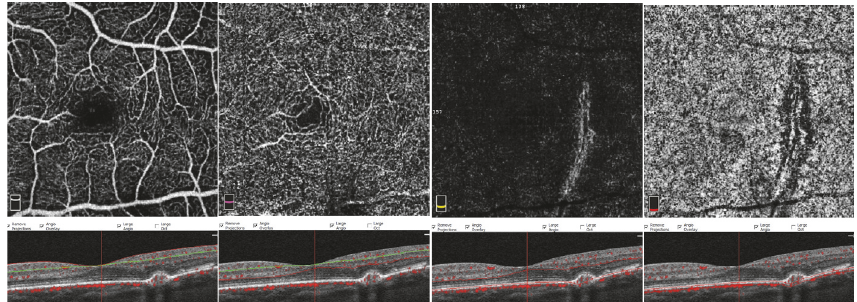
Figure 3: Optical coherence tomography angiography (OCTA): enface angiograms at 6-week visit. OCTA reveals shrinkage of the choriocapillaris defect; enface scan of outer retina and choriocapillaris show no hyperintense flow signal. OCT B-scan demonstrates partial healing of the RPE wound, covered by a less reflective RPE and a reduction of hyperreflective intraretinal material; no subretinal fluid is